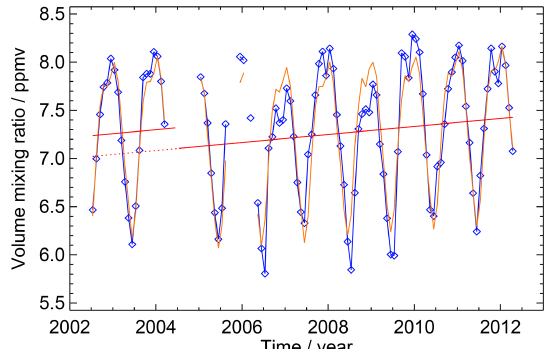
Figure 8. Fit of linear trend, yearly harmonics up to a 2-month pe- riod, and step (arbitrarily assumed to occur in July 2004) to an ozone monthly means time series. Version 8 monthly means at 30km and in a latitude range of 40–50 ◦ S are blue with symbols, while the fit is orange. Linear trend lines are solid red; the trend for the second period is extended into the first period as a red dotted line to bet- ter illustrate the step between FR and RR measurement periods. In this example the fitted linear trend is 0.42ppmv per decade, and the fitted step is −